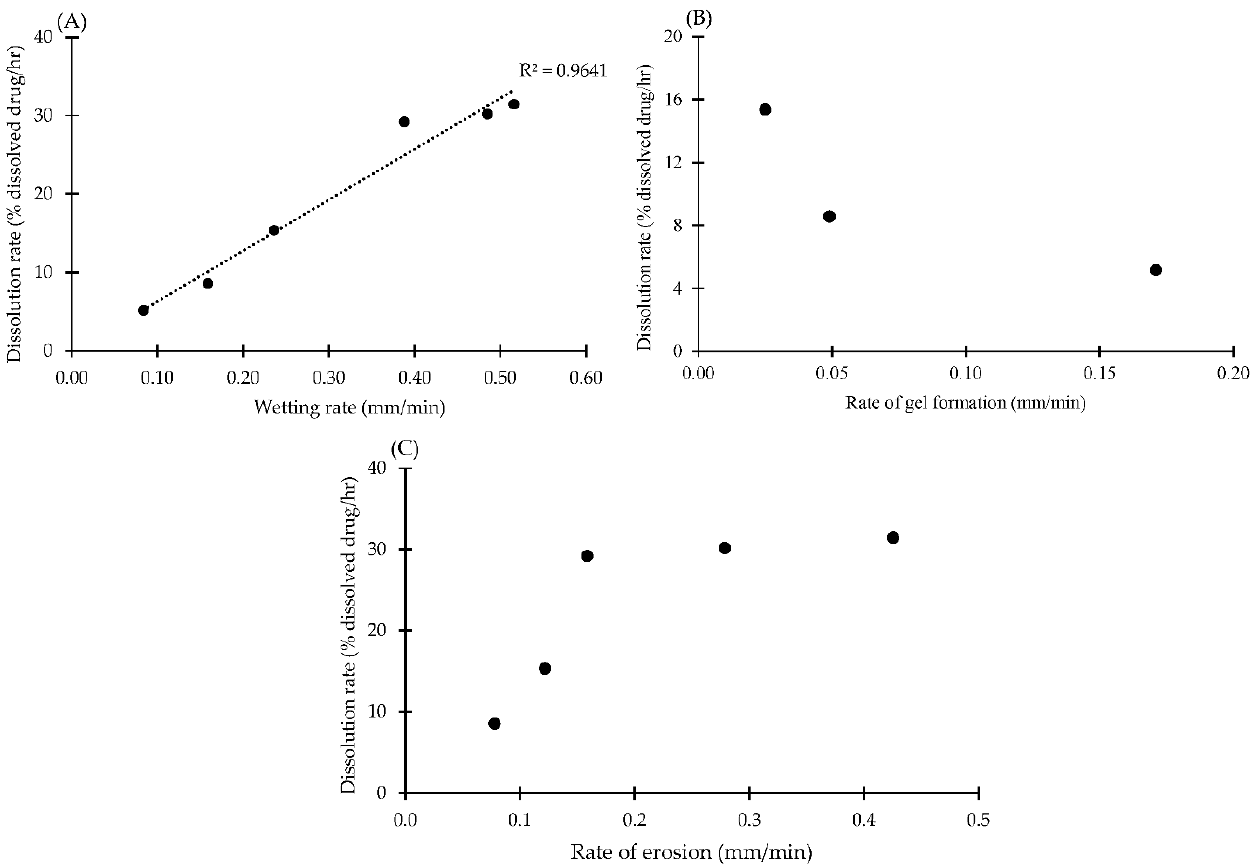
Figure 8. Correlation between rate of wetting ( A ), gel formation ( B ) and erosion ( C ) with dissolution rate of eutectic effervescent tablets in 0.1 N HCl buffer pH 1.2.